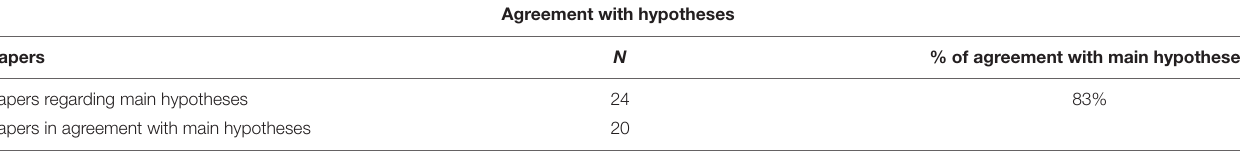
TABLE 2 | Numerical summary of literature mini-review